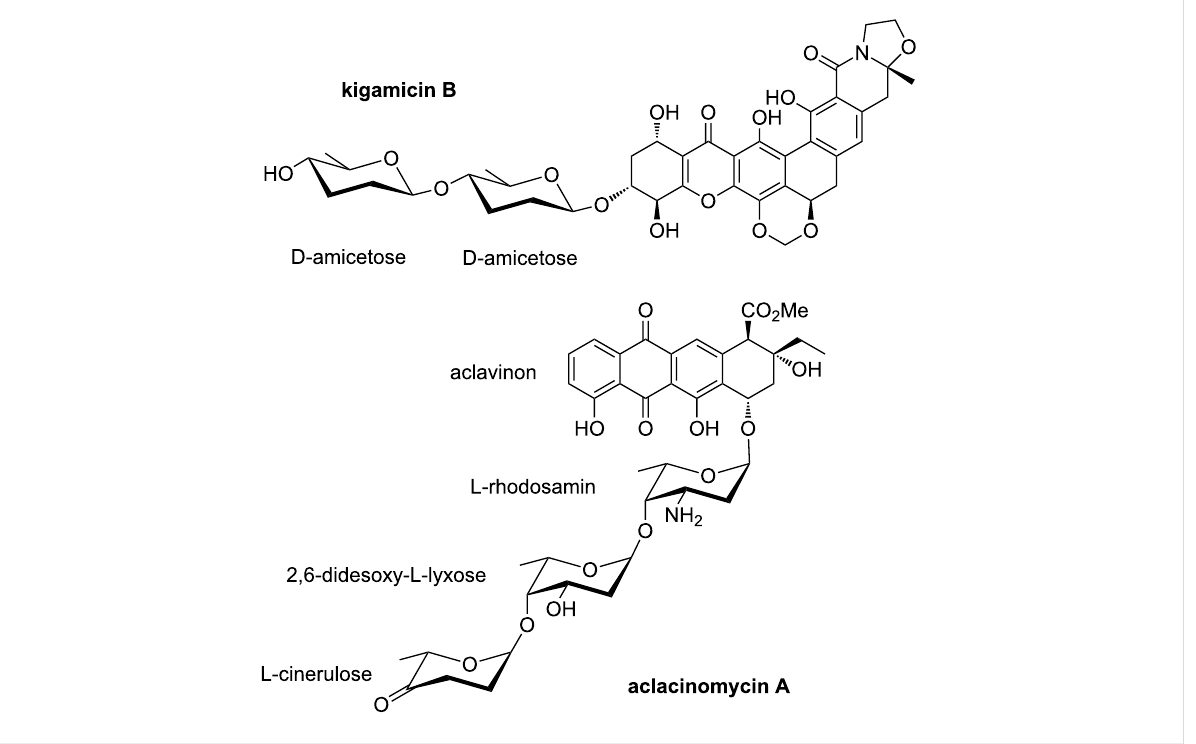
Figure 1: Structures of kigamicin B and aclacinomycin A as representative examples for antineoplastic glycoconjugates.